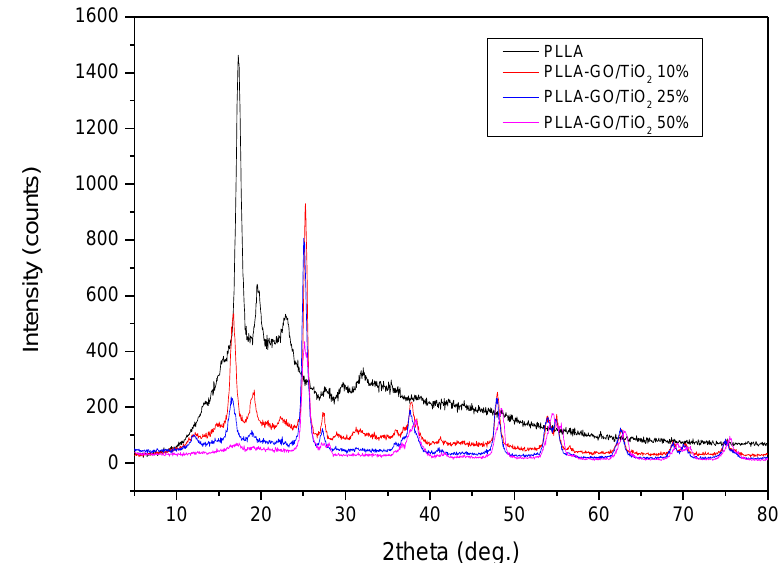
Figure 2. XRD patterns of prepared films containing different GO–TiO 2 contents in comparison with neat PLLA and TiO 2 nanoparticles.